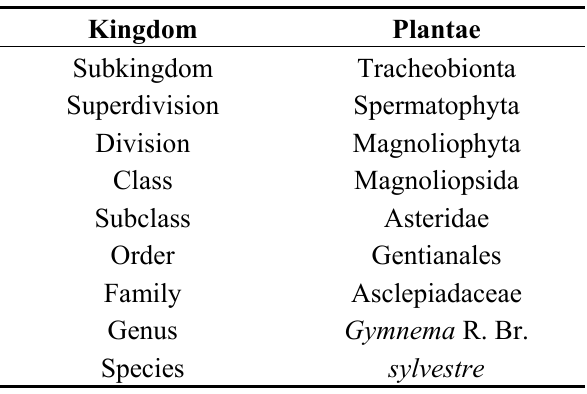
Table 2. Taxonomy of Gymnema sylvestre